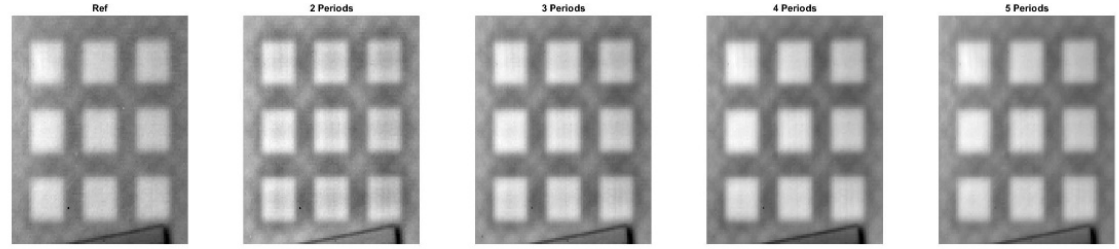
Figure 11. Phase images for the samples with the square cross section defects. A halogen lamp was used as a source of excitation. Defects were placed 0.5 mm under the measured surface.